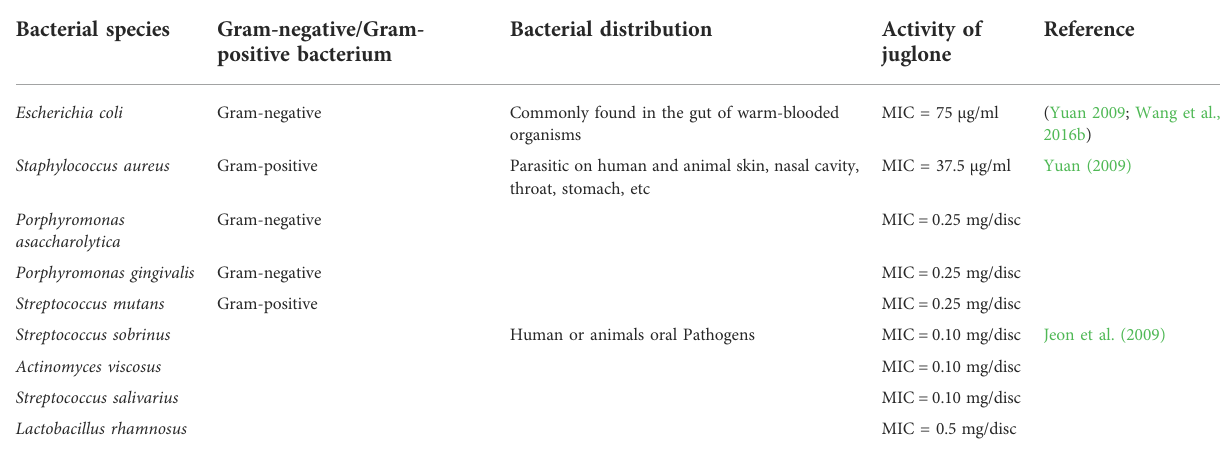
TABLE 3 The antibacterial activities of